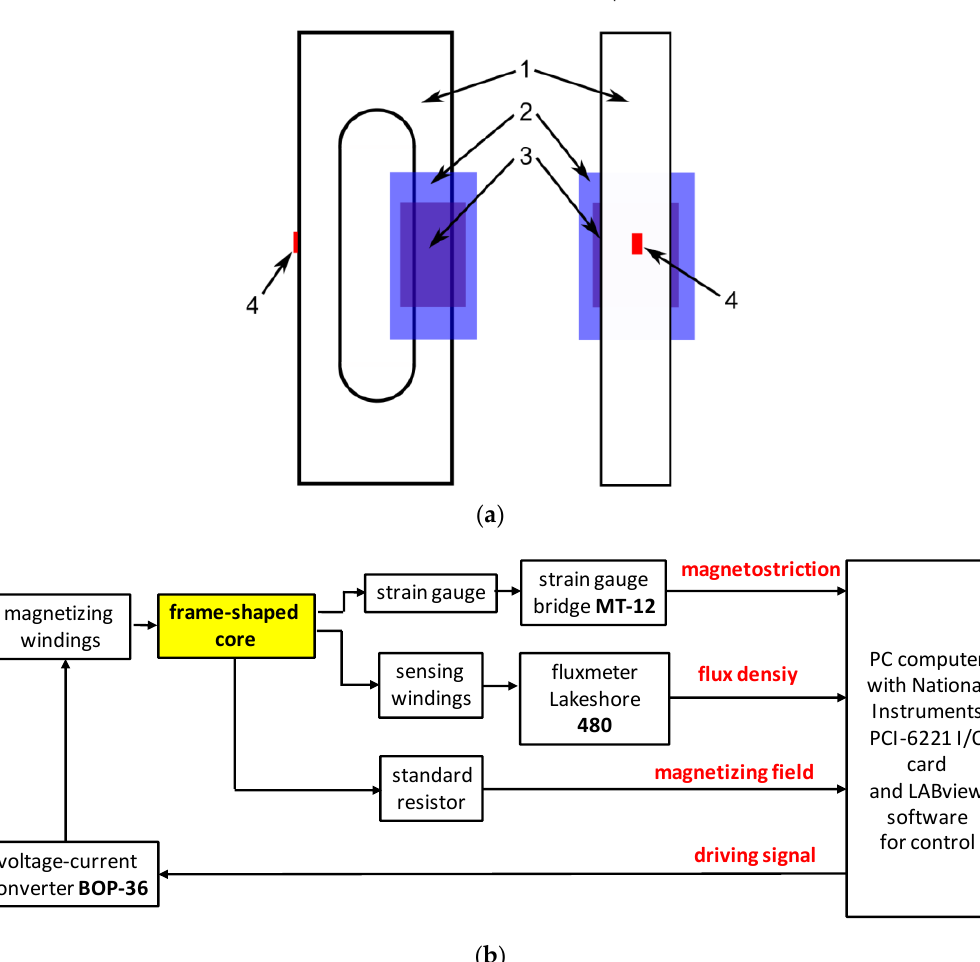
Figure 1. The method of investigation: ( a ) Schematic view of frame-shaped sample: 1 — Tested sample, 2 — magnetizing winding, 3 — sensing winding, 4 — semiconductor strain gauge; ( b ) computer controlled measurement stand enabling simultaneous measurements of magnetostriction λ , flux density B and magnetizing field H.